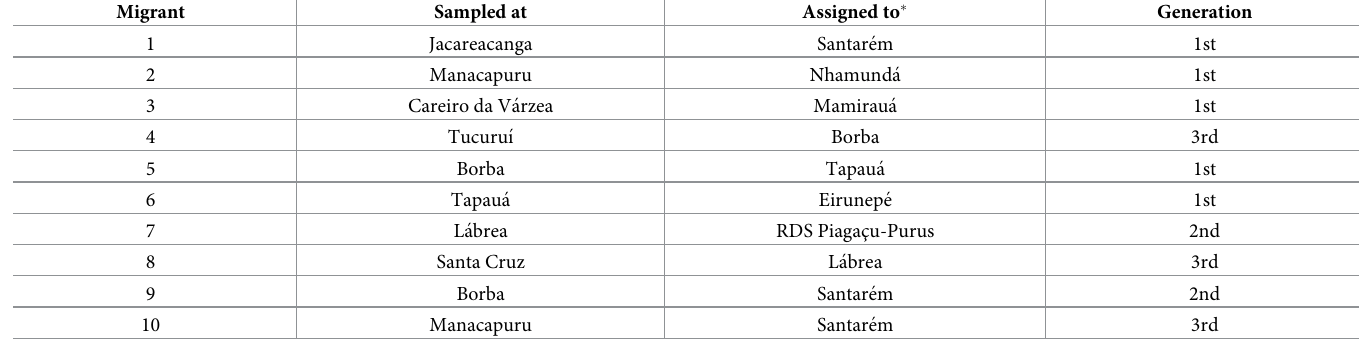
Table 3. Results of Likelihood test implemented in